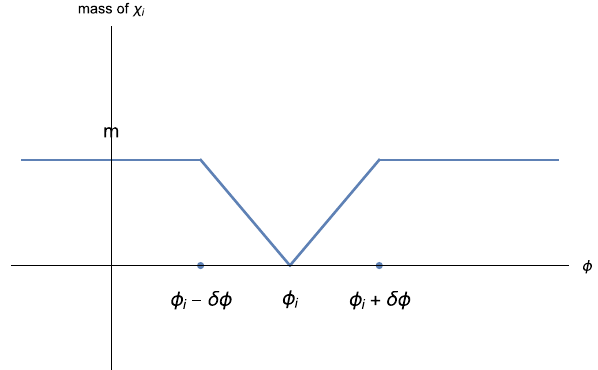
Fig. 3 The χ i mass near the enhanced symmetry point φ